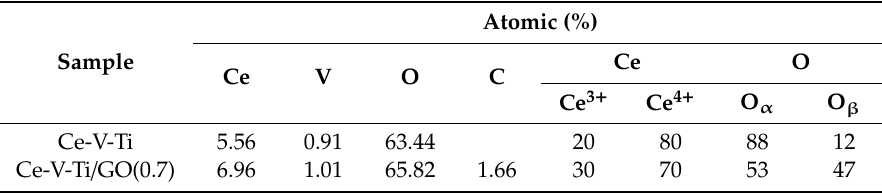
Table 3. Atomic surface compositions of Ce-V-Ti and Ce-V-Ti / GO catalysts obtained by X-ray photoelectron spectroscopy